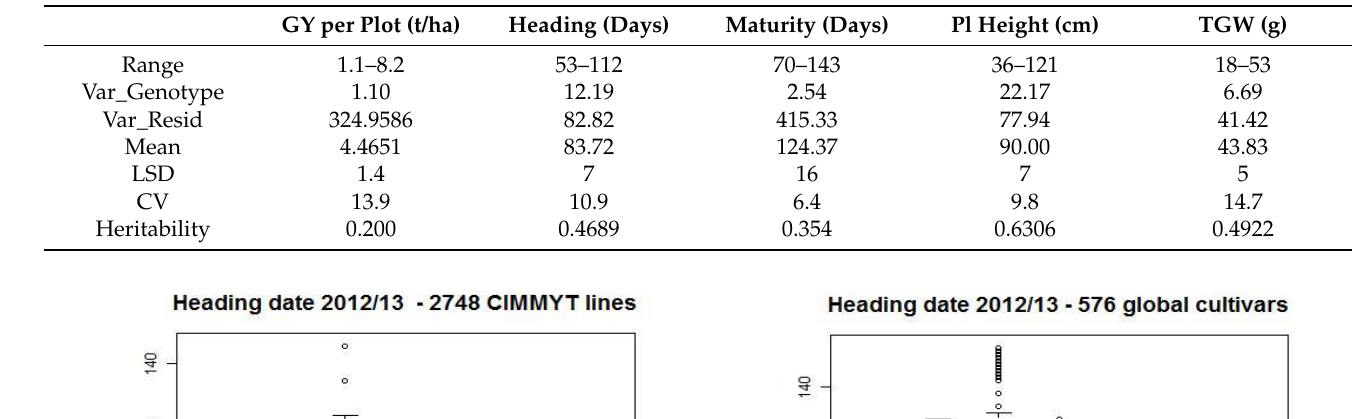
Table 2. Mean and variance for the five traits for 3226 genotypes of wheat when evaluated under six locations of India under early (October) sowing conditions.